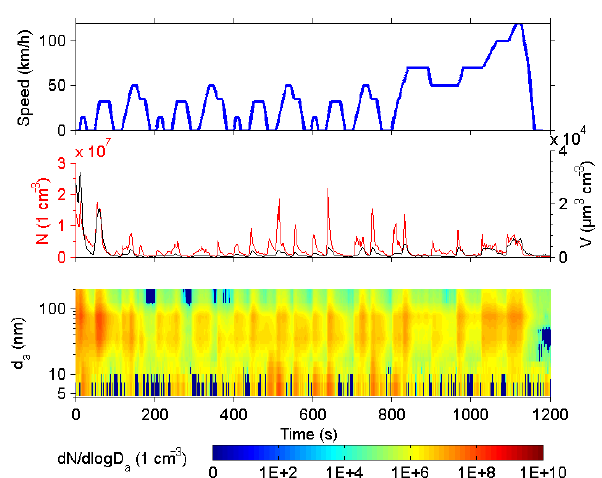
Figure 2. Speed profile, primary particle number (measured by the CPC) and volume concentrations (measured by HRLPI) and pri- mary particle size distributions (HRLPI) for the studied gasoline passenger car during the NEDC test